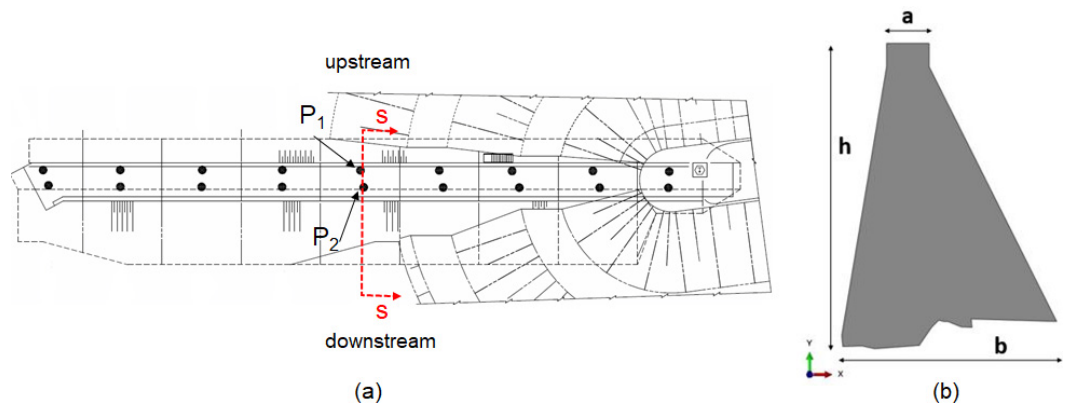
Figure 6. ( a ) Location of the monitoring instruments in the studied gravity dam and ( b ) the 2D section s – s considered for the